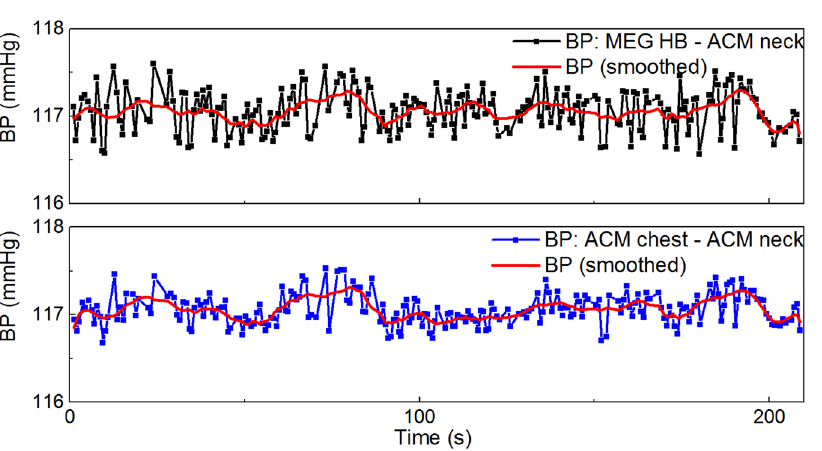
Figure 6. A comparison of BP oscillations when using two PTT calculation methods simultaneously. In the upper plot, BP is based on the PTT calculation between when ACMs are placed on chest and neck. In the lower plot, PTT is between heart beats determined by MEG and ACM placed on neck. The values calculated for BP are not absolute, because the calibration procedure was omitted. Red curve shows averaged responses for